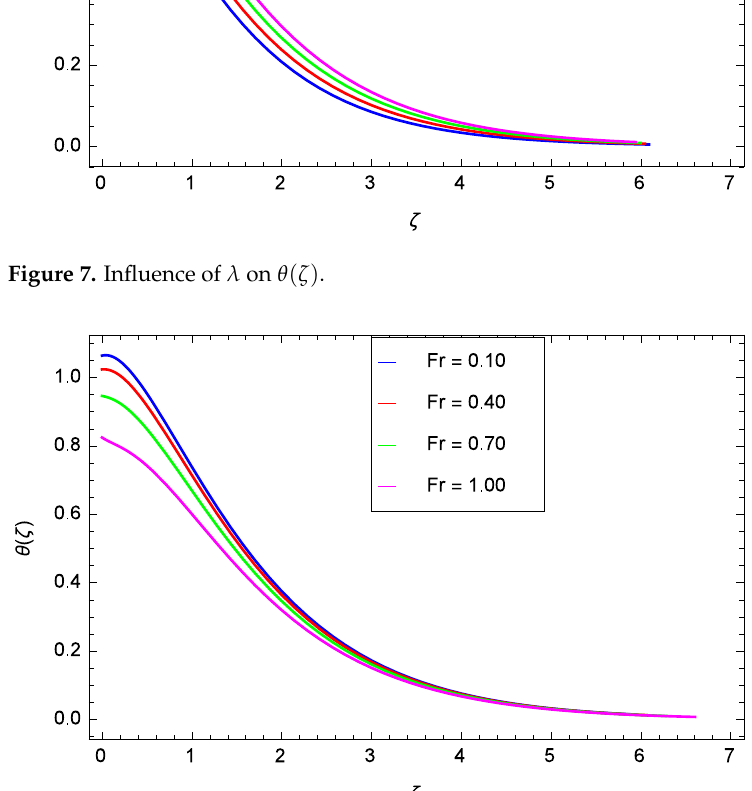
Figure 8. Influence of Fr on θ ( ζ )